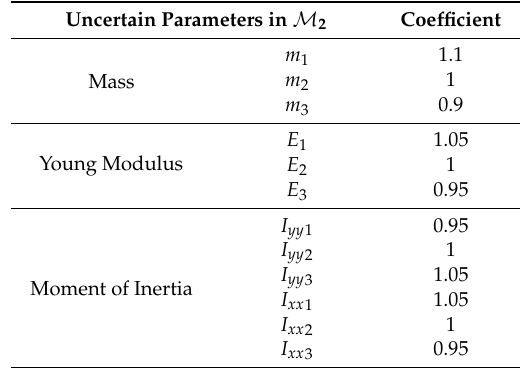
Table 2. Disturbance coefficients for structural model parameter components to introduce modeling uncertainties in model class M 2 .